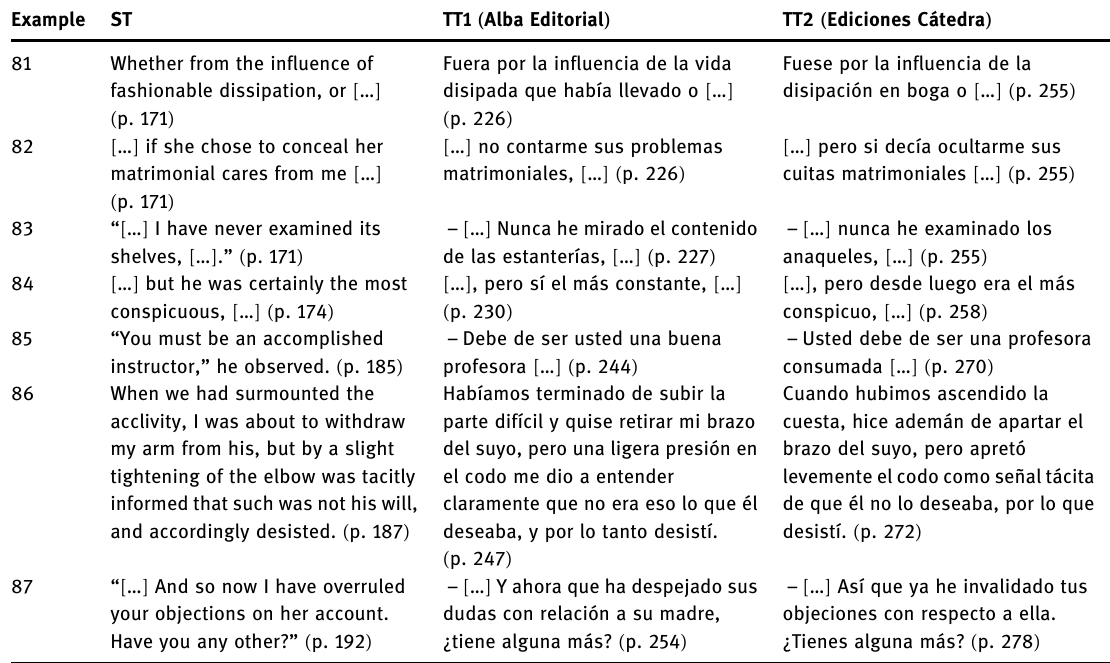
Table 16: Examples taken from Chapters 22, 23, 24 and 25 Example